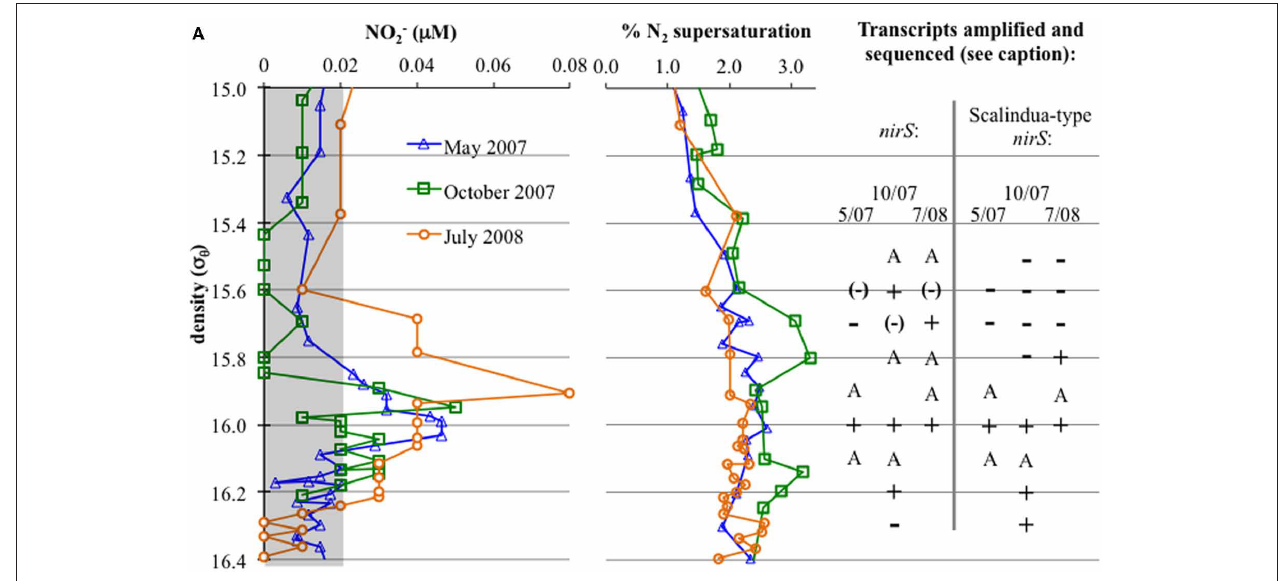
FIGURE 2 | Left: NO − 2 concentrations, with a gray box indicating values at or below detection limit. Right: First, N 2 supersaturation (from N 2 /Ar ratio compared to calculated values for saturation); N 2 is produced in situ in the lower suboxic zone. To the right, detection of gene transcripts: “A” indicates